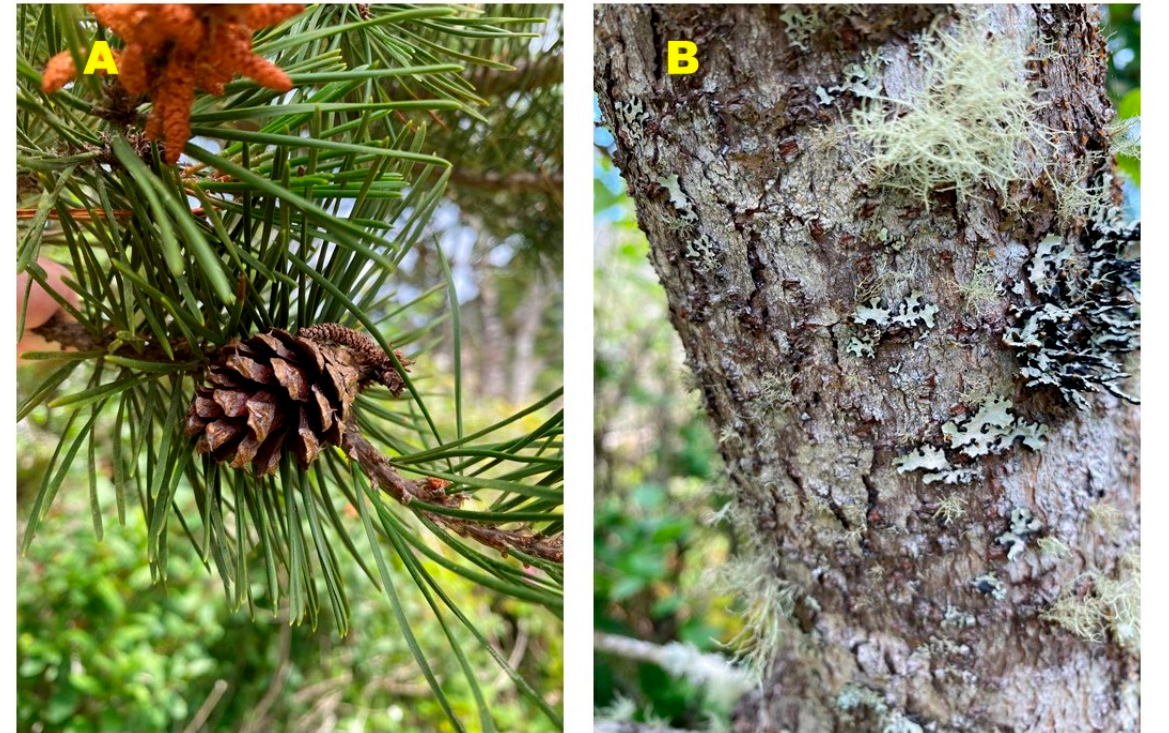
Figure 2. Pinus contorta subsp. contorta from the central Oregon coast. ( A ) Leaves (needles) and cone. ( B ) bark.